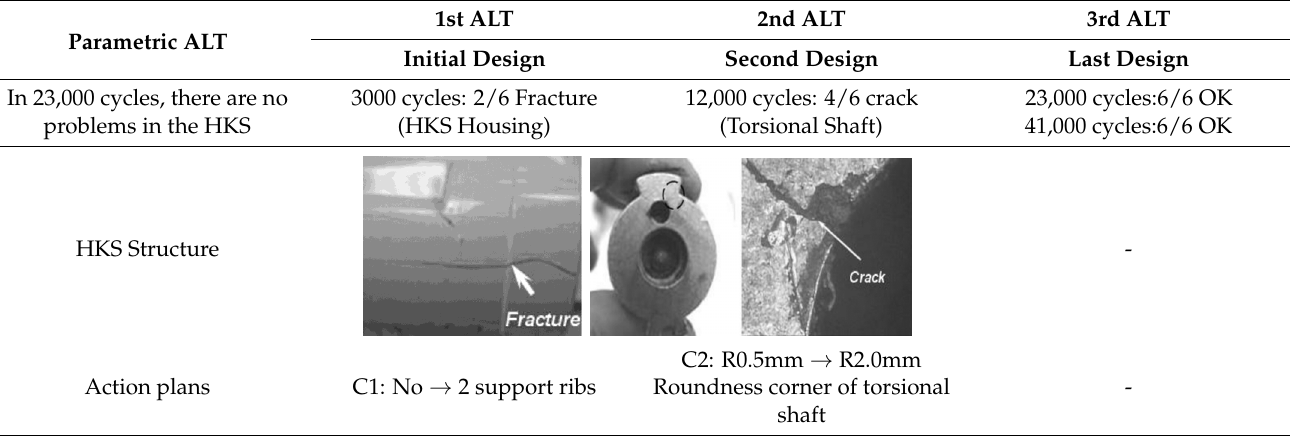
Table 3. Results of